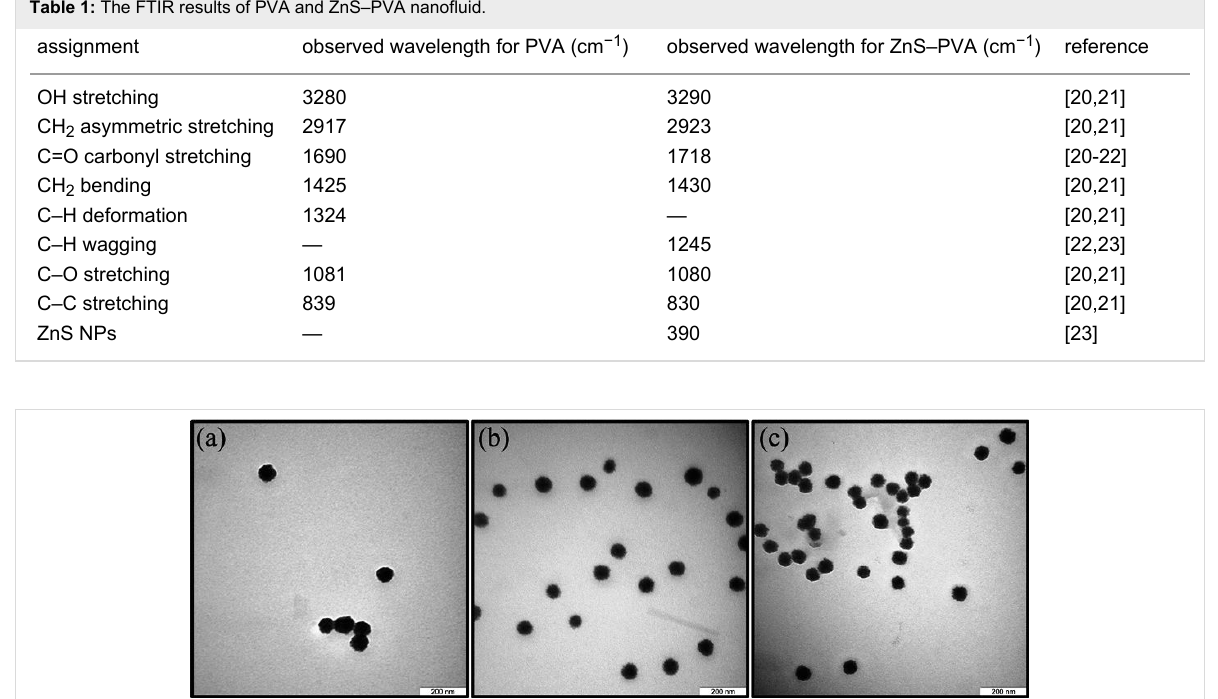
Figure 3: TEM images of ZnS NPs within PVA matrix at (a) 10 kGy, (b) 30 kGy and (c) 50 kGy dose.